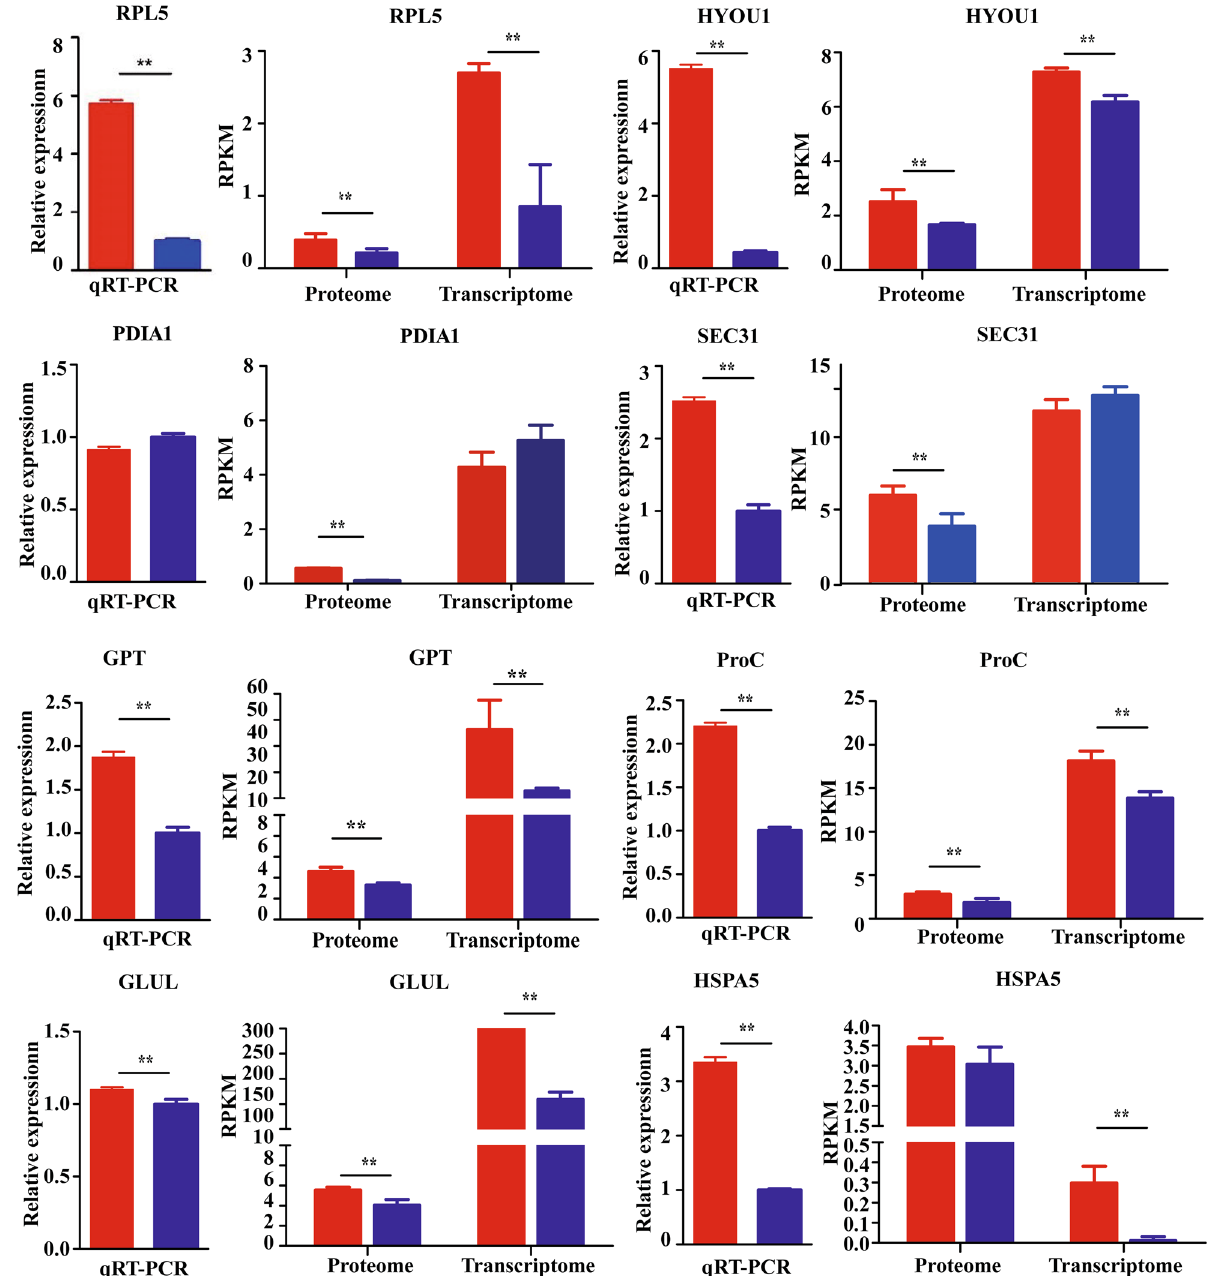
Figure 8. Relative transcript expression of selected differentially expressed proteins and genes identified through combined analysis. Relative expression of each gene was normalized with the actin signal. Red bars represent NIL-723, and blue bars represent NIL-1010. RPL5, ribosomal protein L5; HYOU1, hypoxia up-regulated 1; PDIA1, Protein disulfide-isomerase A1; SEC31, COPII coat complex component secretory31; GPT, glutamic-pyruvic transaminase; ProC, proline C; GLUL, glutamate-ammonia ligase; HSPA5, heat shock 70 kDa protein 5. Bars indicate means ± standard deviations (SDs) of at least three independent biological replicates. Two asterisks indicate a significant difference at p < 0:01. Statistical analysis was performed with SPSS Statistics 26.0 software (https:// www. ibm. com/ produ cts/ spss- stati